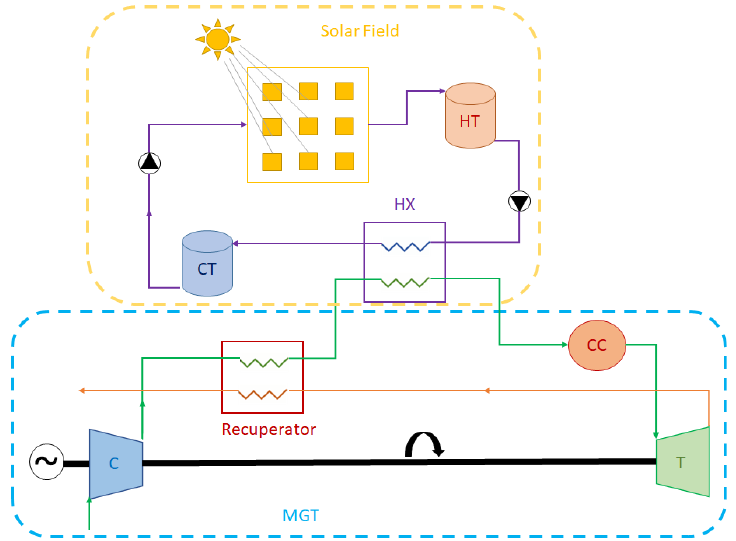
Figure 8. Generic layout of a hybrid MGT-solar power plant.